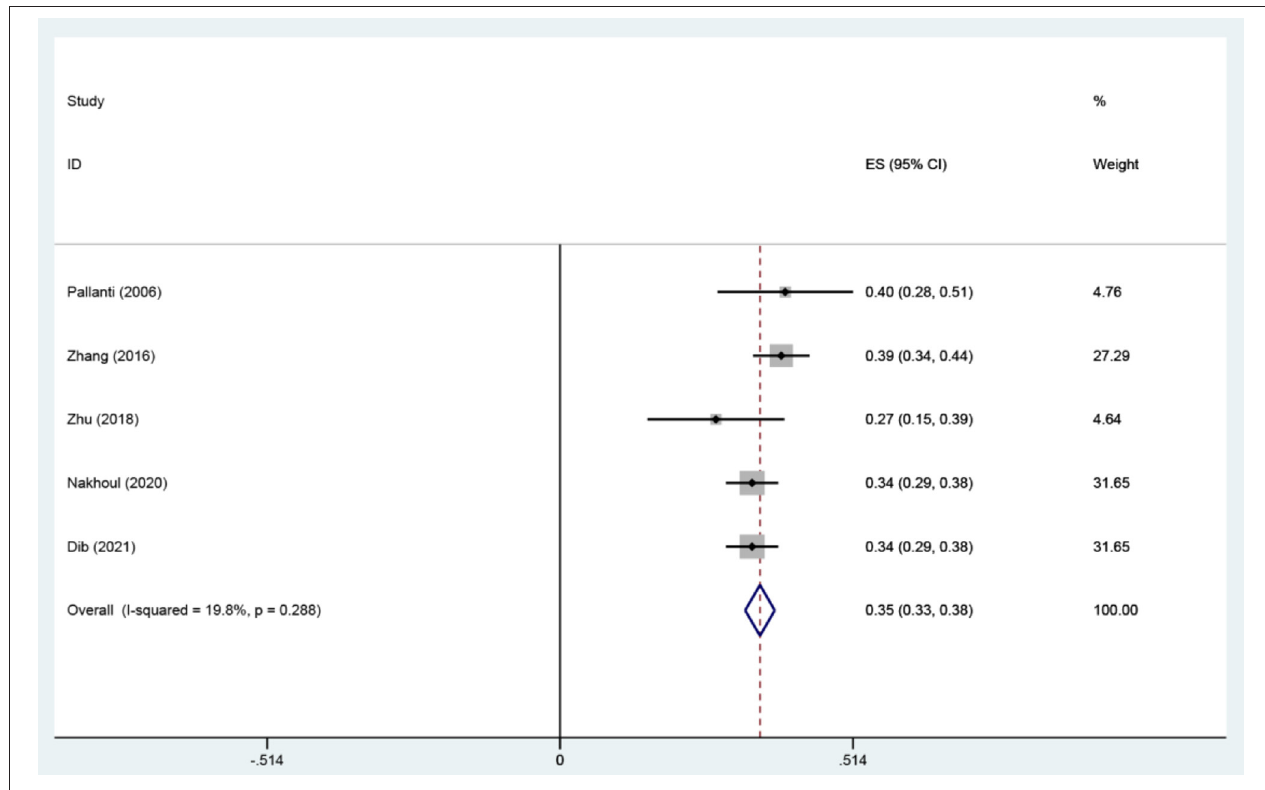
FIGURE 3 | The association between IAD and smoking (r).